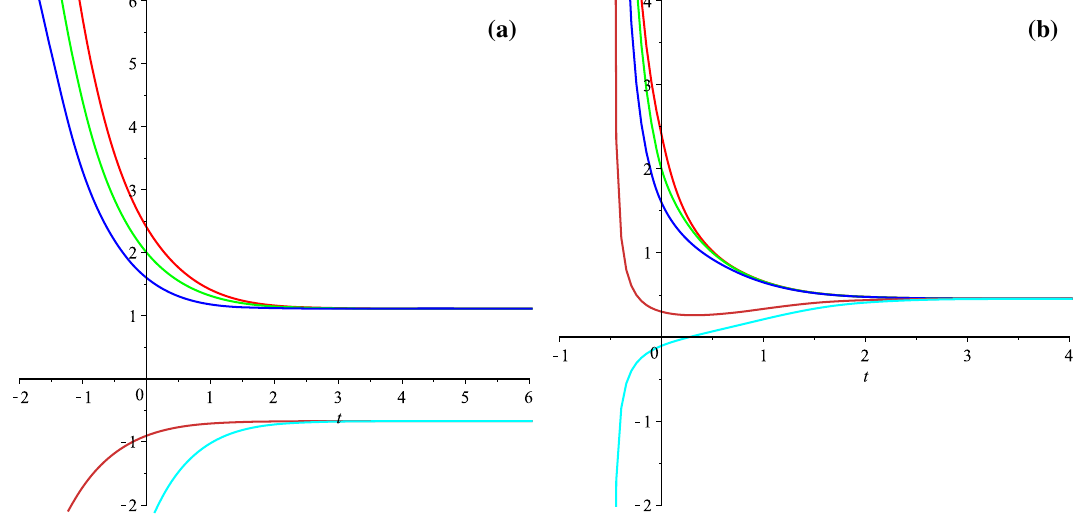
Fig. 2 Typical evolution curve for stable anisotropic a and isotropic b exponential solutions with broken symmetry in both subspaces in the D = 2 case (see the text for more